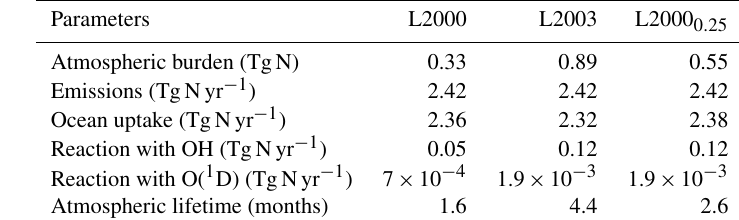
Table 4. Global burden, budget terms, and atmospheric lifetimes for three model HCN tracers.